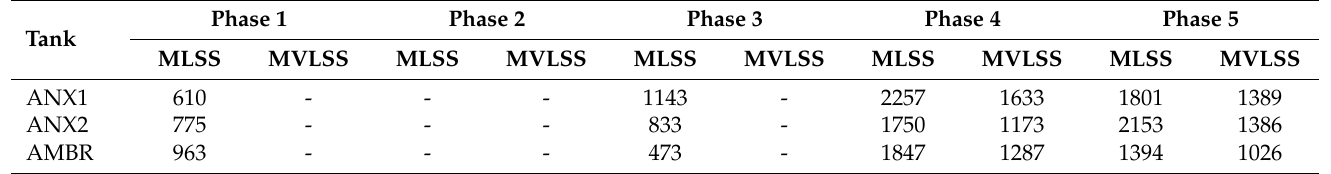
Table 5. Average of MLSS and MLVSS of ANX and AMBR reactors during each